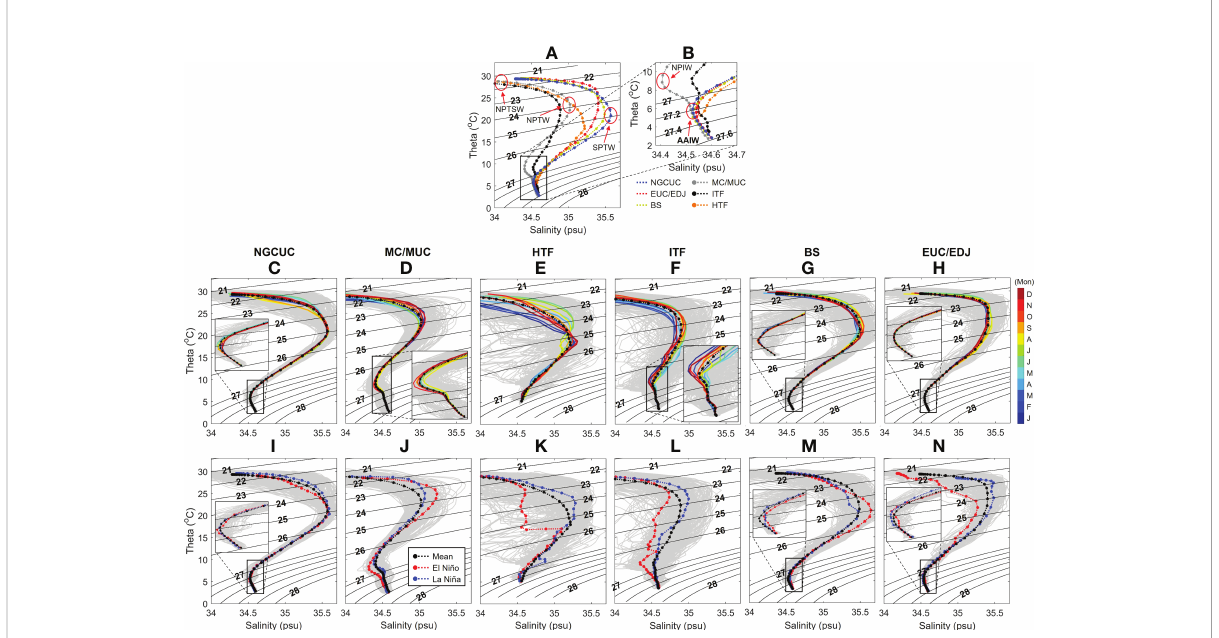
FIGURE 12 (A) q -S diagrams at six locations (i.e., 1.5°S, 140°E [blue, NGCUC]; 8°N, 127.5°E [grey, MC/MUC]; 1°S, 128.75°E [orange, HTF]; 3.25°N, 125°E [black, ITF]; 3.5°S, 148.5°E [yellow, BS]; equator, 160°E [red, EUC/EDJ], see Figure 2) estimated from model outputs and averaged from 1994 to 2015. (B) Same as (A) but for the q -S ranges of black rectangular that shown in (A) . Except (A) and (B) , the fi rst- to sixth-column panels represent the q -S diagrams at NGCUC (C, I) , MC/MUC (D, J) , HTF (E, K) , ITF (F, L) , BS (G, M) , and EUC/EDJ (H, N) regions, respectively. The second- (third-) row panels are q -S diagrams with monthly climatology (ENSO) phases. In the second- and third-row panels, the daily (mean) q -S diagrams along whole period are shown by grey (black)